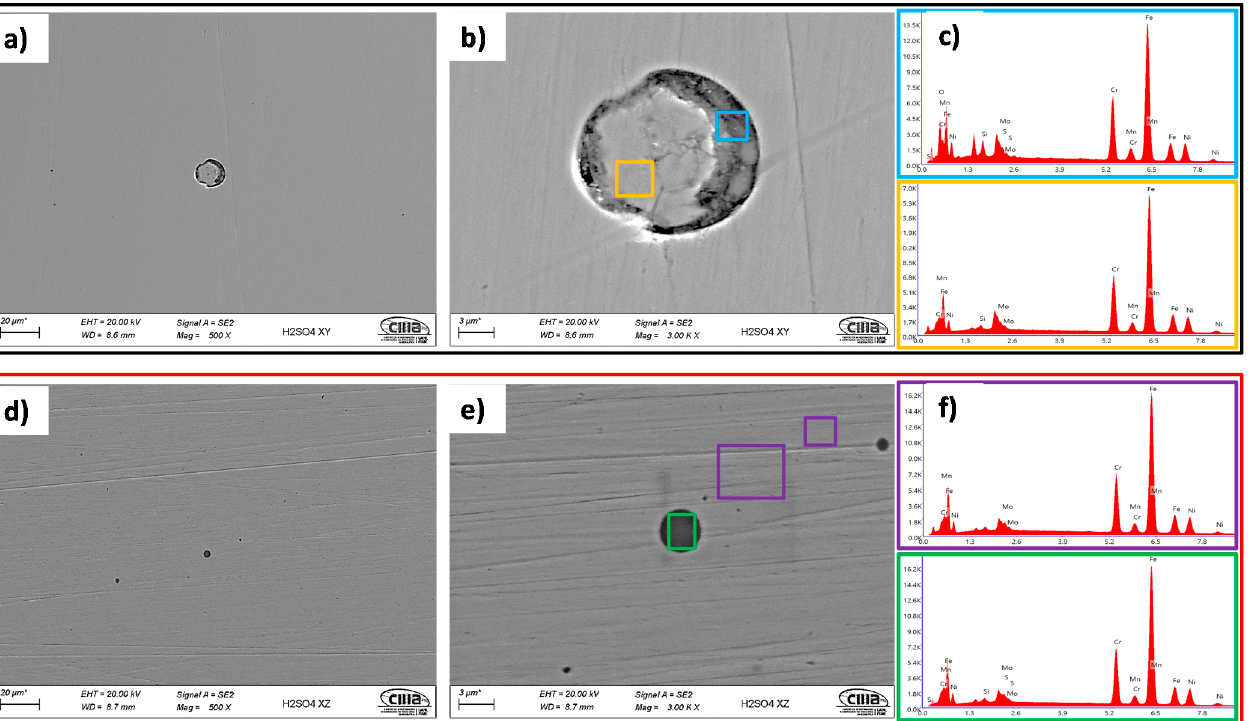
Figure 14. Morphologies of the specimens after the electrochemical tests in H 2 SO 4 at 500X and 1000X. XY plane ( a – c ); XZ plane ( d , e , f ). ZEISS EVO scanning electron microscope (SEM).